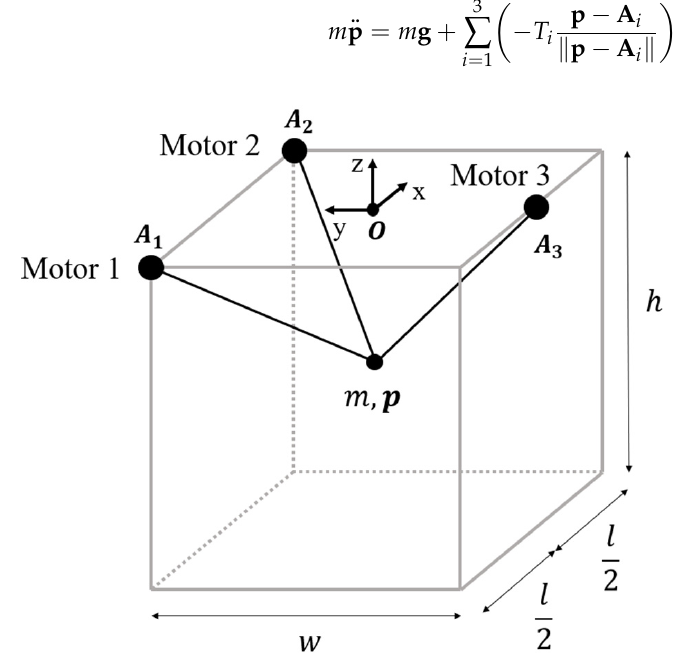
Figure 1. Scheme of the studied CSPR. p = [ x y z ] T ∈ R 3 is the vector of the absolute end-effector